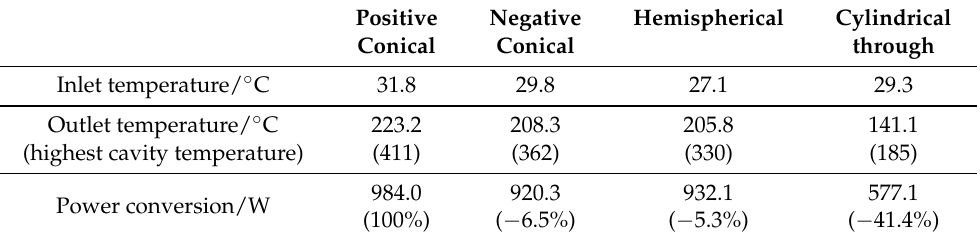
Table 8. Power conversion for different geometries